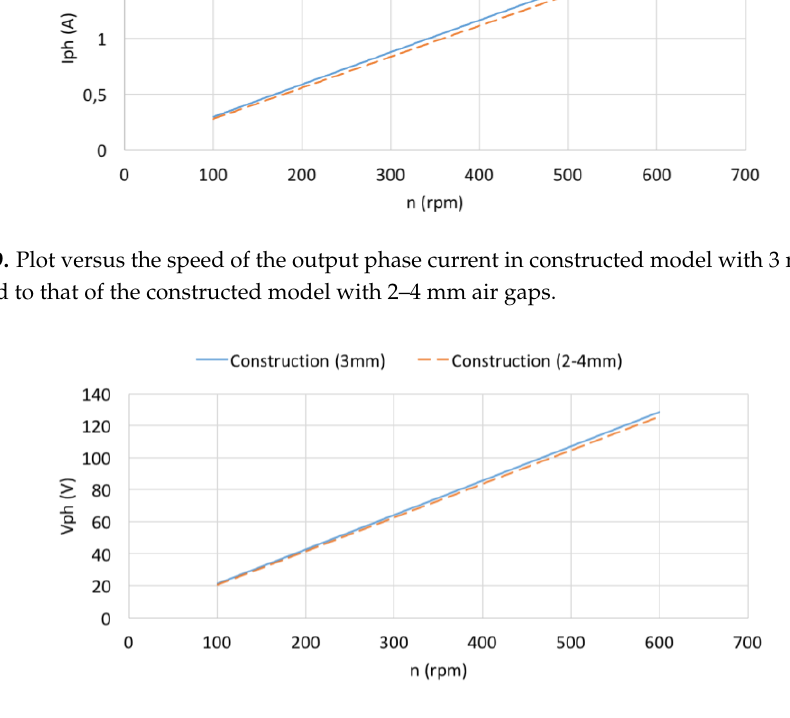
Figure 20. Plot versus the speed of the terminal phase voltage in constructed model with 3 mm air gaps compared to that of the constructed model with 2–4 mm air gaps.